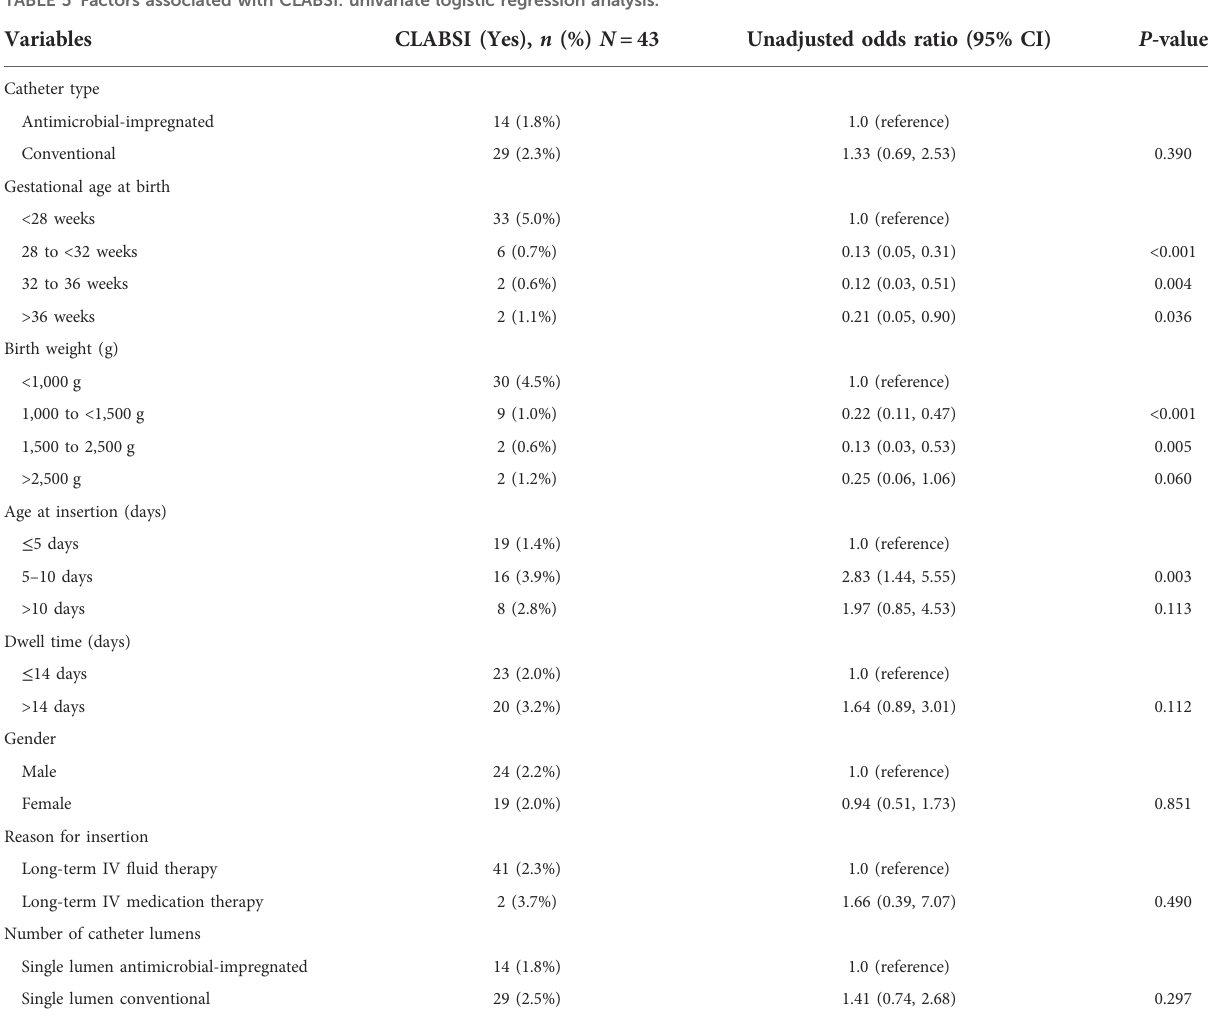
TABLE 5 Factors associated with CLABSI: univariate logistic regression analysis. Variables CLABSI (Yes), n (%) N = 43 Unadjusted odds ratio (95% CI) P